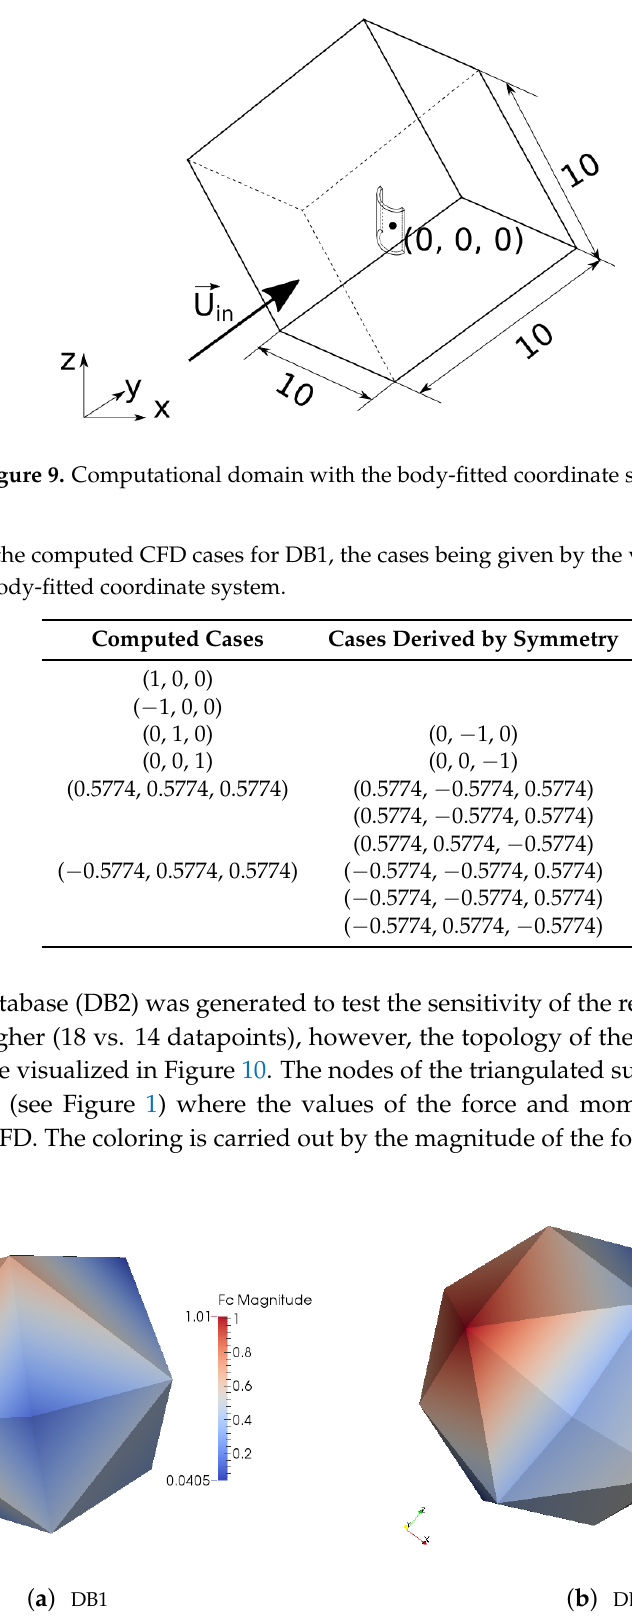
Figure 10. Visualisation of the databases used for 6DOF computations by isocolors of the force coefficient magnitude for different orientations of the relative